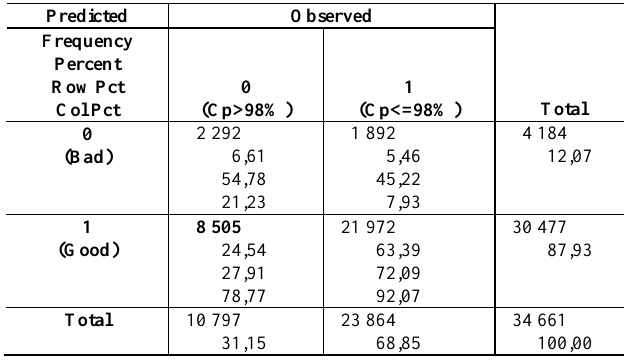
Table 1: Predicted probability split at 0,5